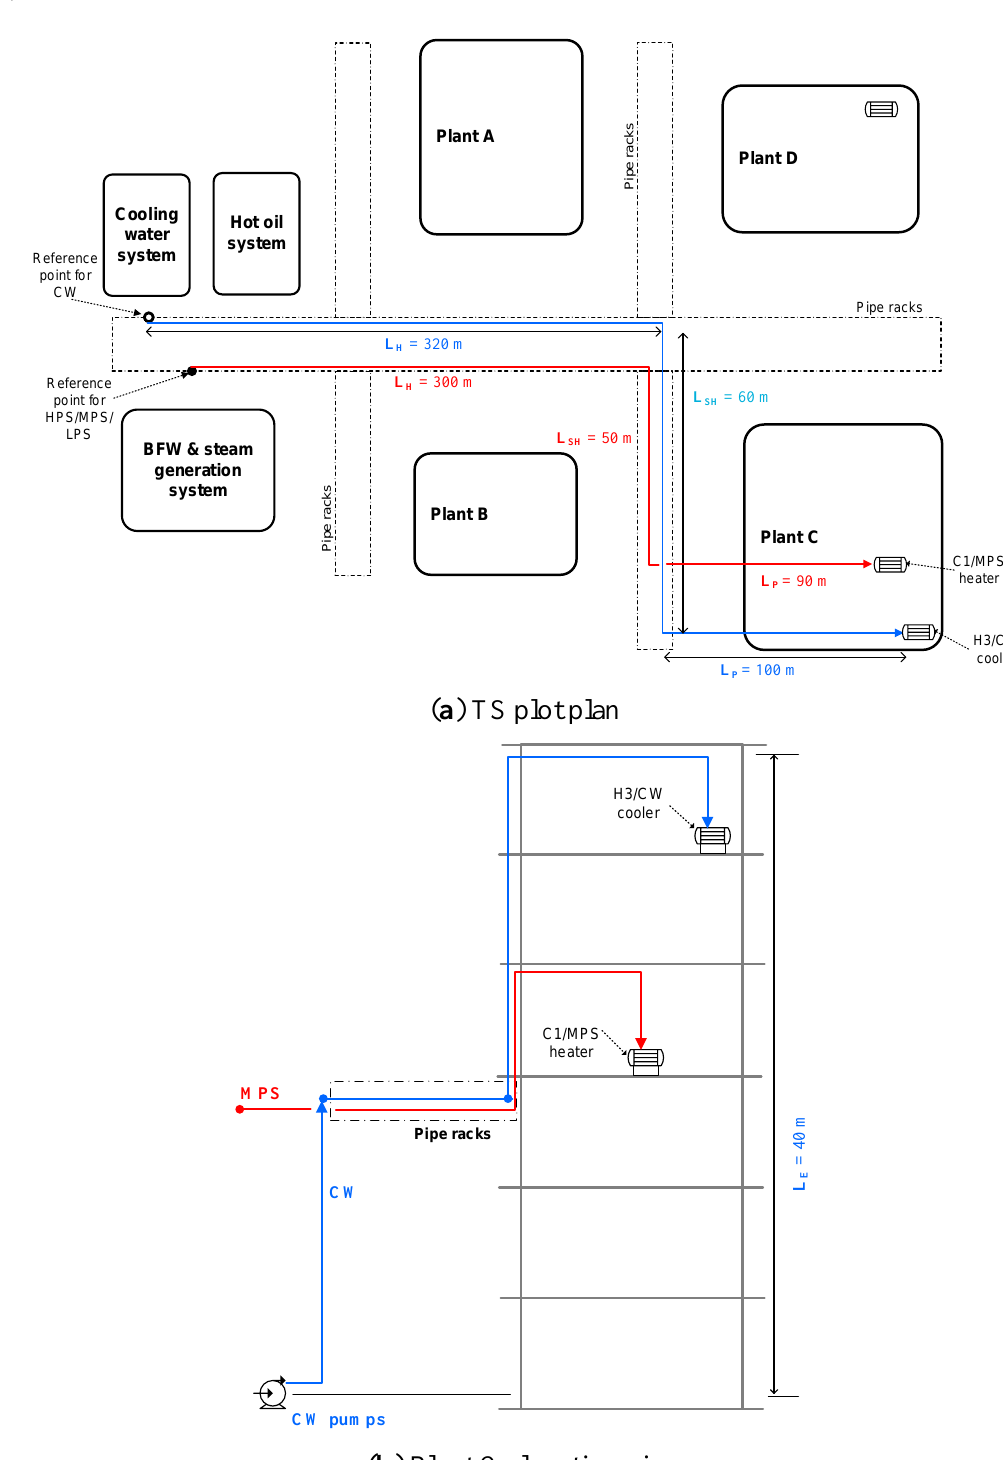
Figure 7. Simplified plot plan and elevation drawing for the